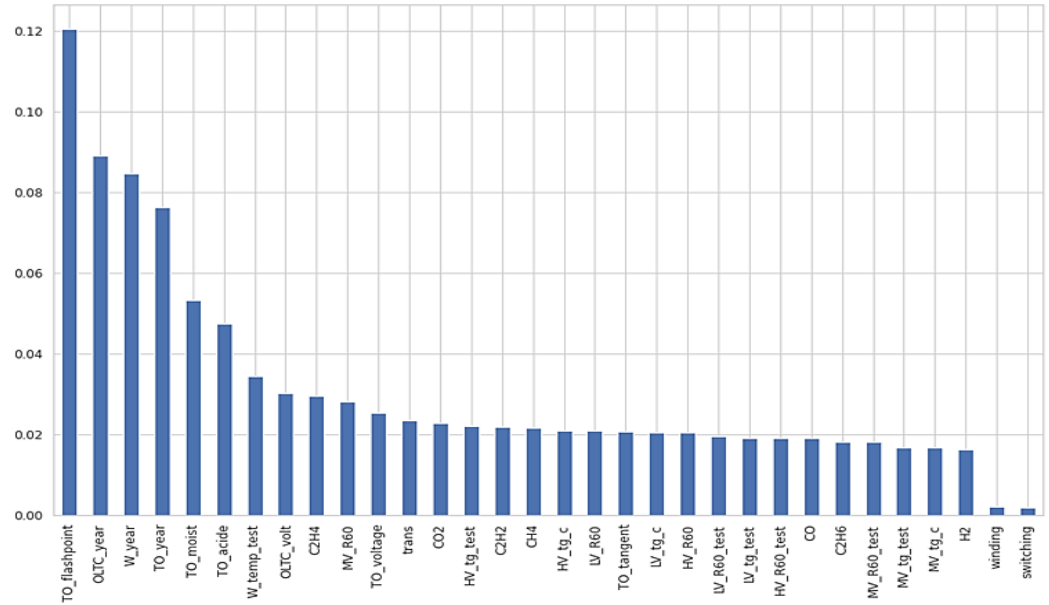
Figure 10. Feature importance analysis for the preliminary ensemble model.